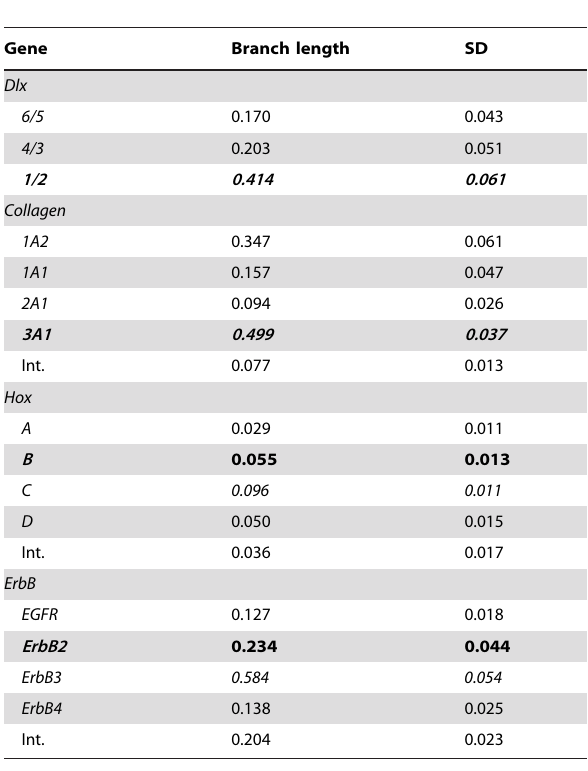
Table 1. Branch length data for the stem of Dlx , Col , Hox and ErbB clusters.